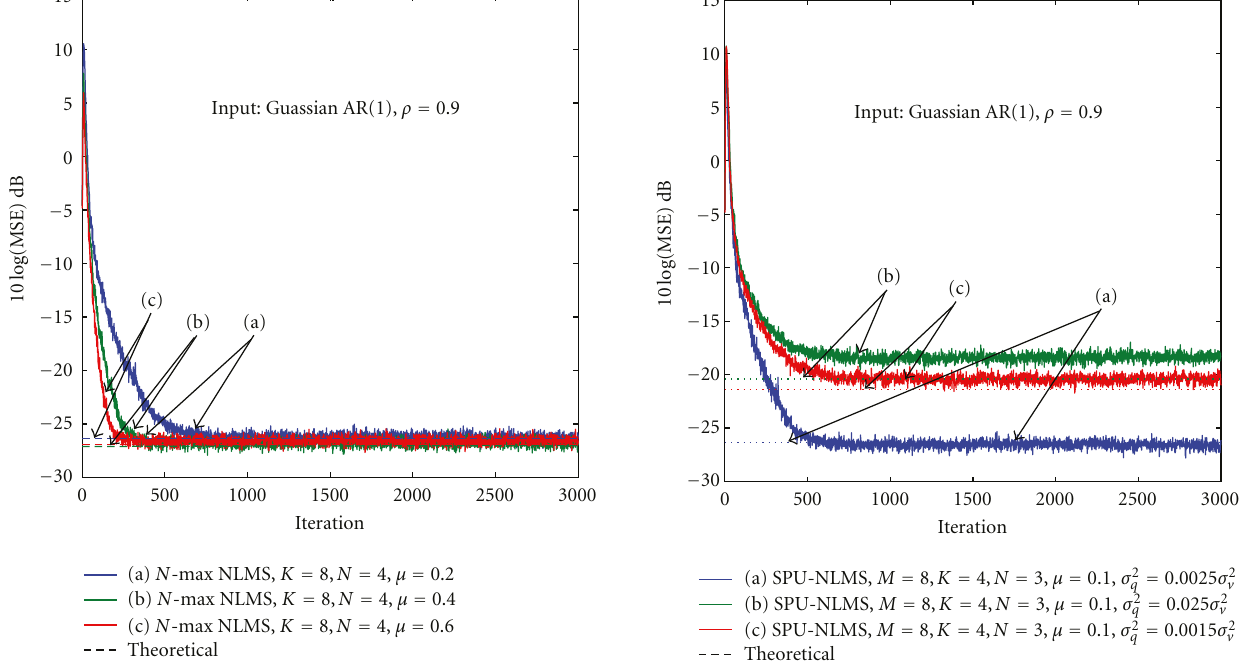
Figure 14: Learning curves of SPU-NLMS with M = 8, K = 4 and N = 3 for di ff erent degree of nonstationary and for colored Gaussian input